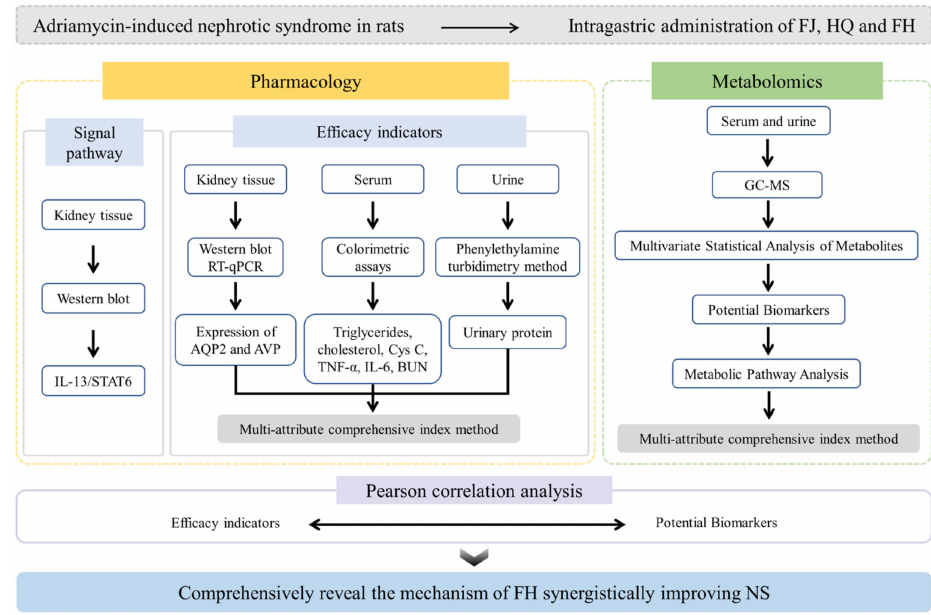
Figure 1. The study design of this work to reveal the mechanism of synergistic improvement of nephrotic syndrome by the Stephania tetrandra – Astragalus membranaceus herbal